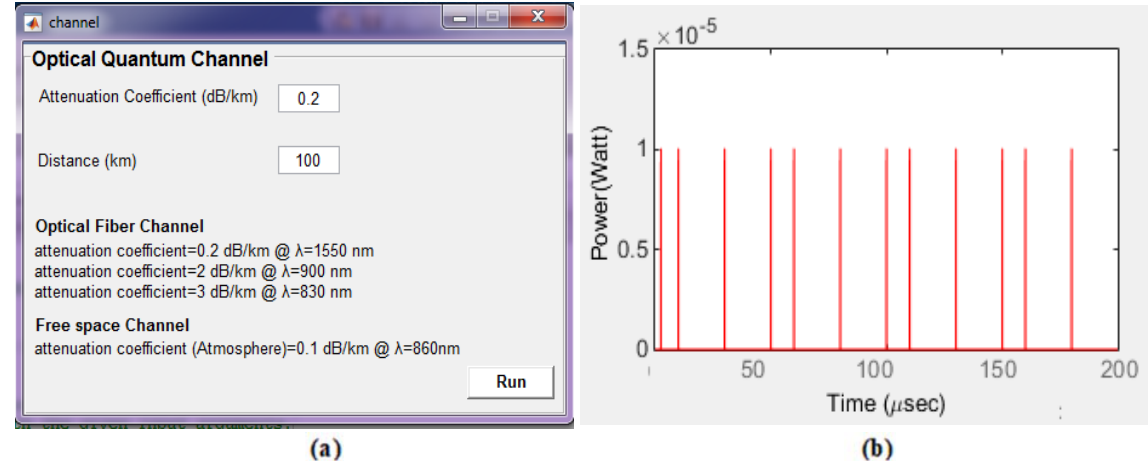
Fig. 6. Test 1 (a) GUI set up (b) result for OF quantum channel for L =100km and α_p=0.2